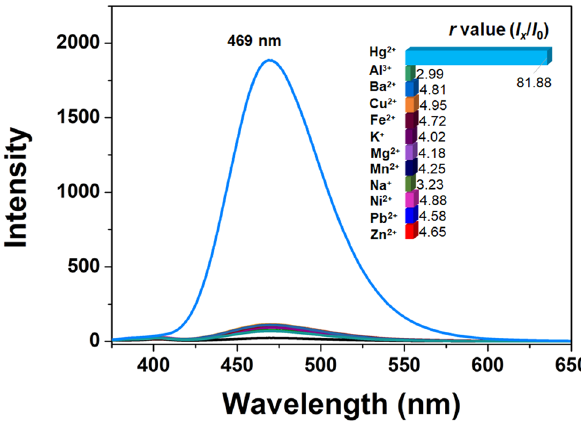
Figure 5: Fluorescence spectra of HNTs - PHT in aqueous solution ([ c ] = 1.0 mg/mL ) with the addition of Hg 2 + , Zn 2 + , Pb 2 + , Ni + , Na + , Mn 2 + , Mg 2 + , K + , Fe 2 + , Cu 2 + , Ba 2 + and Al 3 + ( the concentration of each ion is equal to 1 × 10 − 5 M )